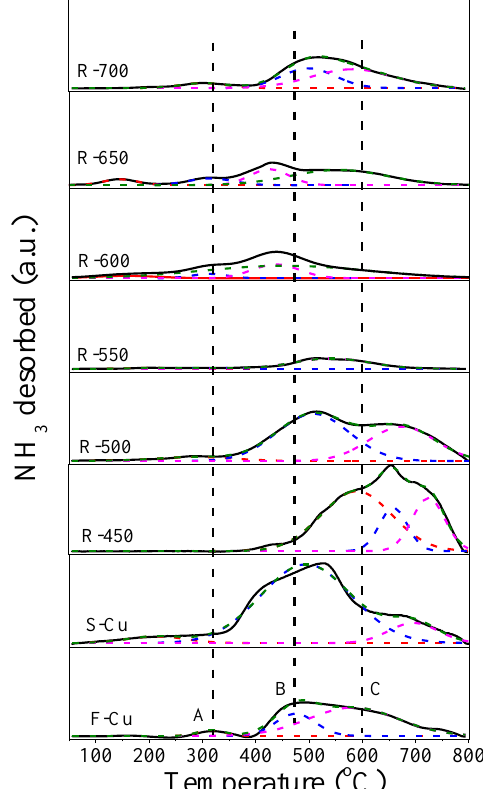
Figure 8. Temperature programmed desorption (TPD) profiles of Cu-SSZ-13 catalysts in fresh, sulfated and regenerated states.